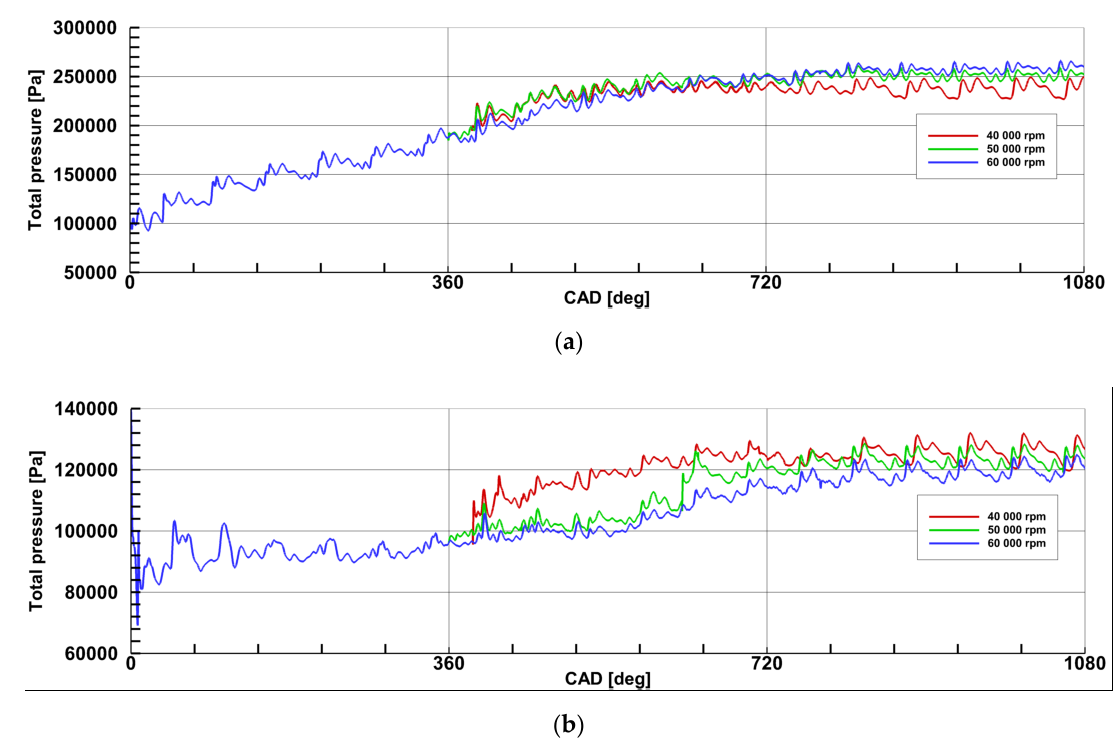
Figure 13. The pressure plots monitored for three different turbine speeds for the 3 revolutions of the crankshaft at: ( a ) the Section 2-2; ( b ) the Section 4-4.